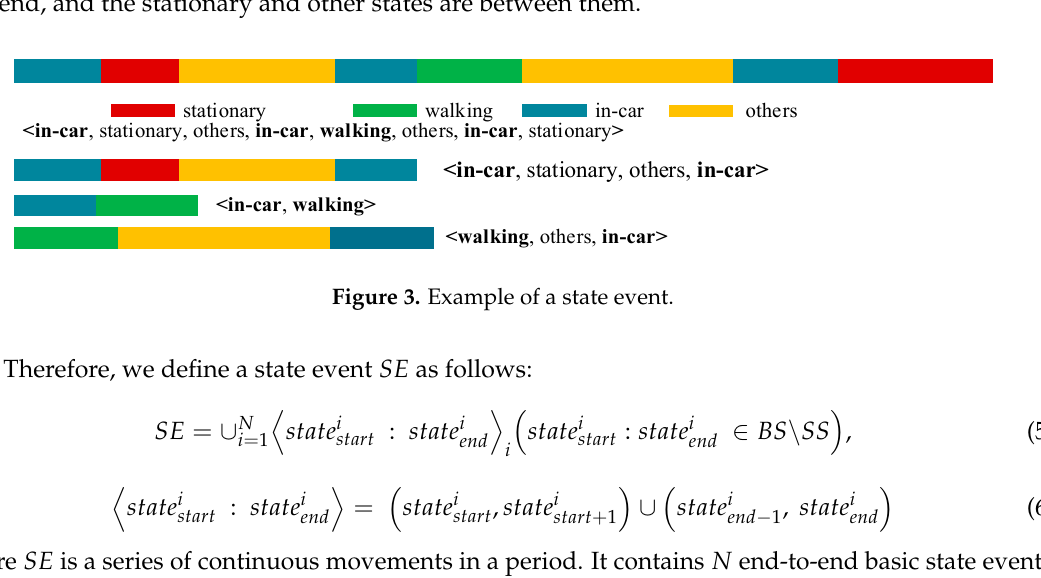
Table 1. Basic state events.